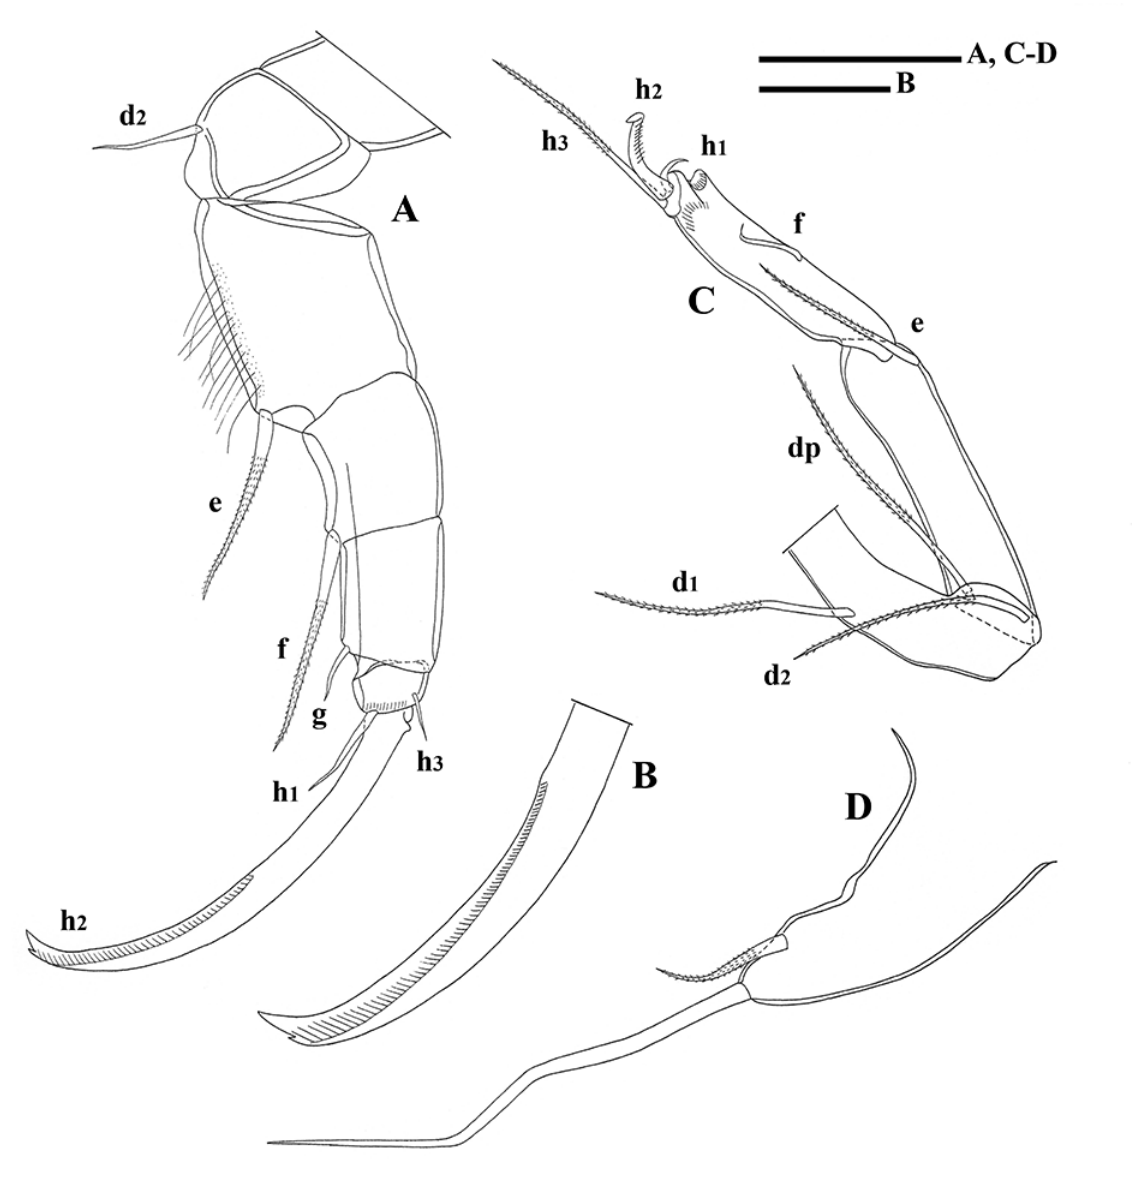
Fig. 4. Thaicypridopsis longispinosa sp. nov., ♀♀. A. T2 (MSU-ZOC.257). B. Distal part of T2 terminal claw (idem). C. T3 (idem). D. CR (MSU-ZOC.264). Scale bars: A, C = 50 µm; B, D = 20